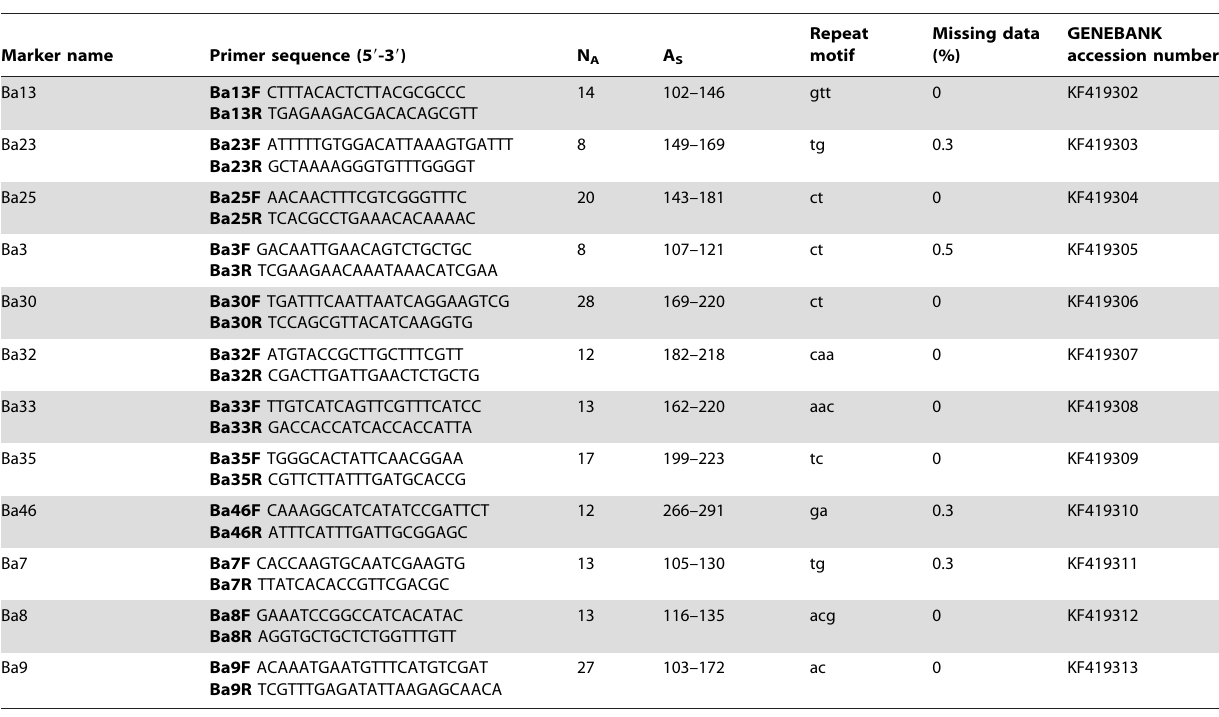
Table 1. Characteristics of the microsatellite markers used in the study.